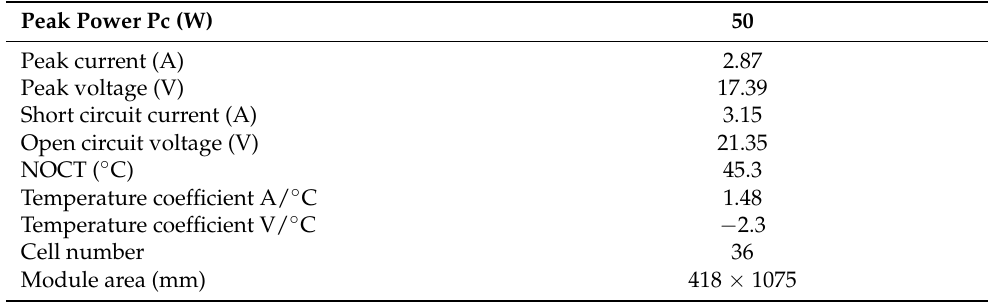
Table 3. Characteristics of panel technology.